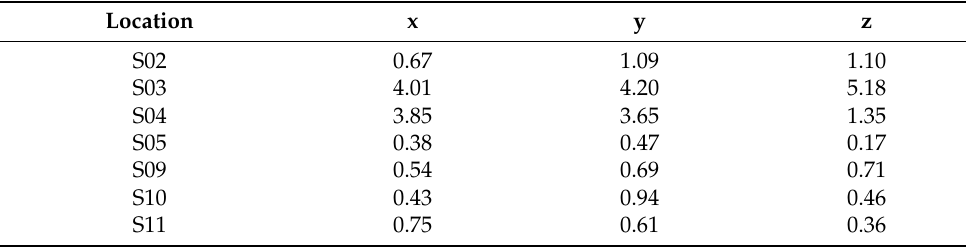
Table 1. Maximum values of velocity (mm/s).